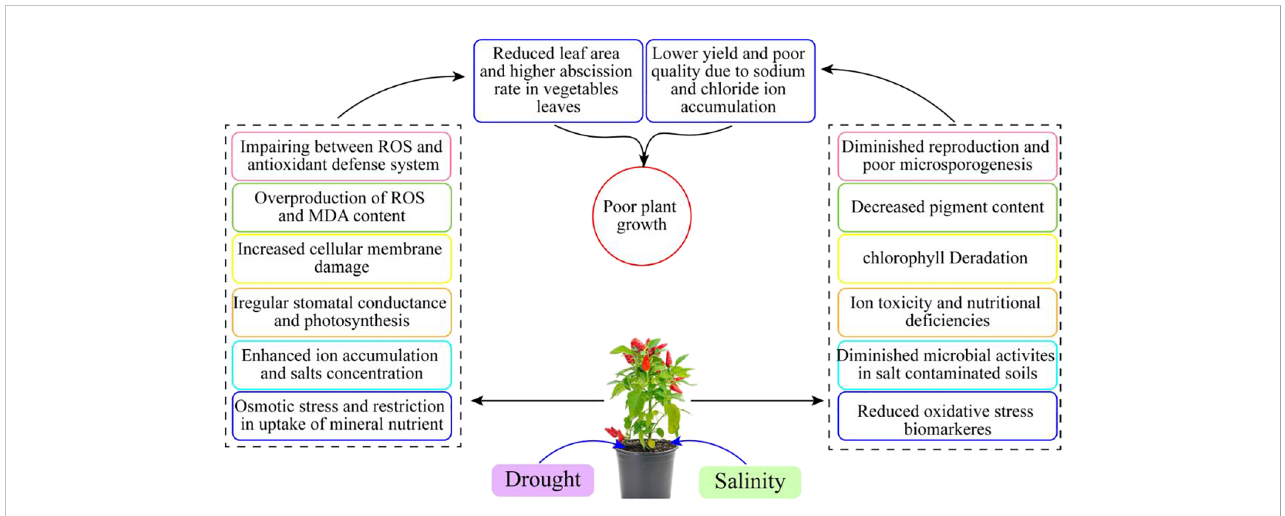
FIGURE 1 Adverse effects of salinity in vegetable